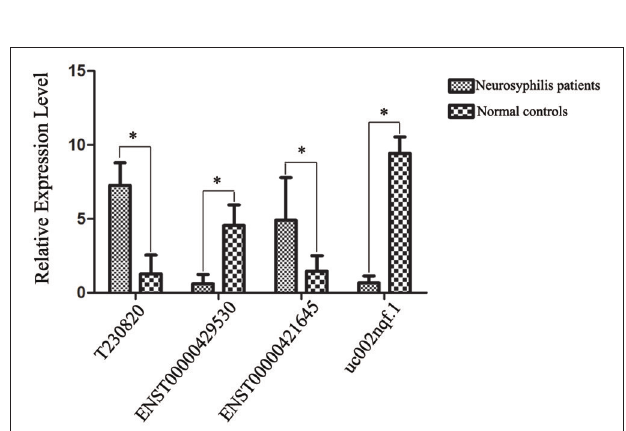
FIGURE 5 | Confirmation of lncRNA expression by RT-qPCR. After normalization to β -actin expression, data were processed as the mean ± SD, and the average expression value for each lncRNA was used for the subsequent statistical analysis. Statistical analysis of the two groups was performed using Student’s t -test. Four lncRNAs were differentially expressed between the two groups. *Significant difference between the healthy controls ( n = 23) and neurosyphilis patients ( n = 20). A P < 0.05 was considered statistically significant. Each reaction was run three times, with technical triplicates for each